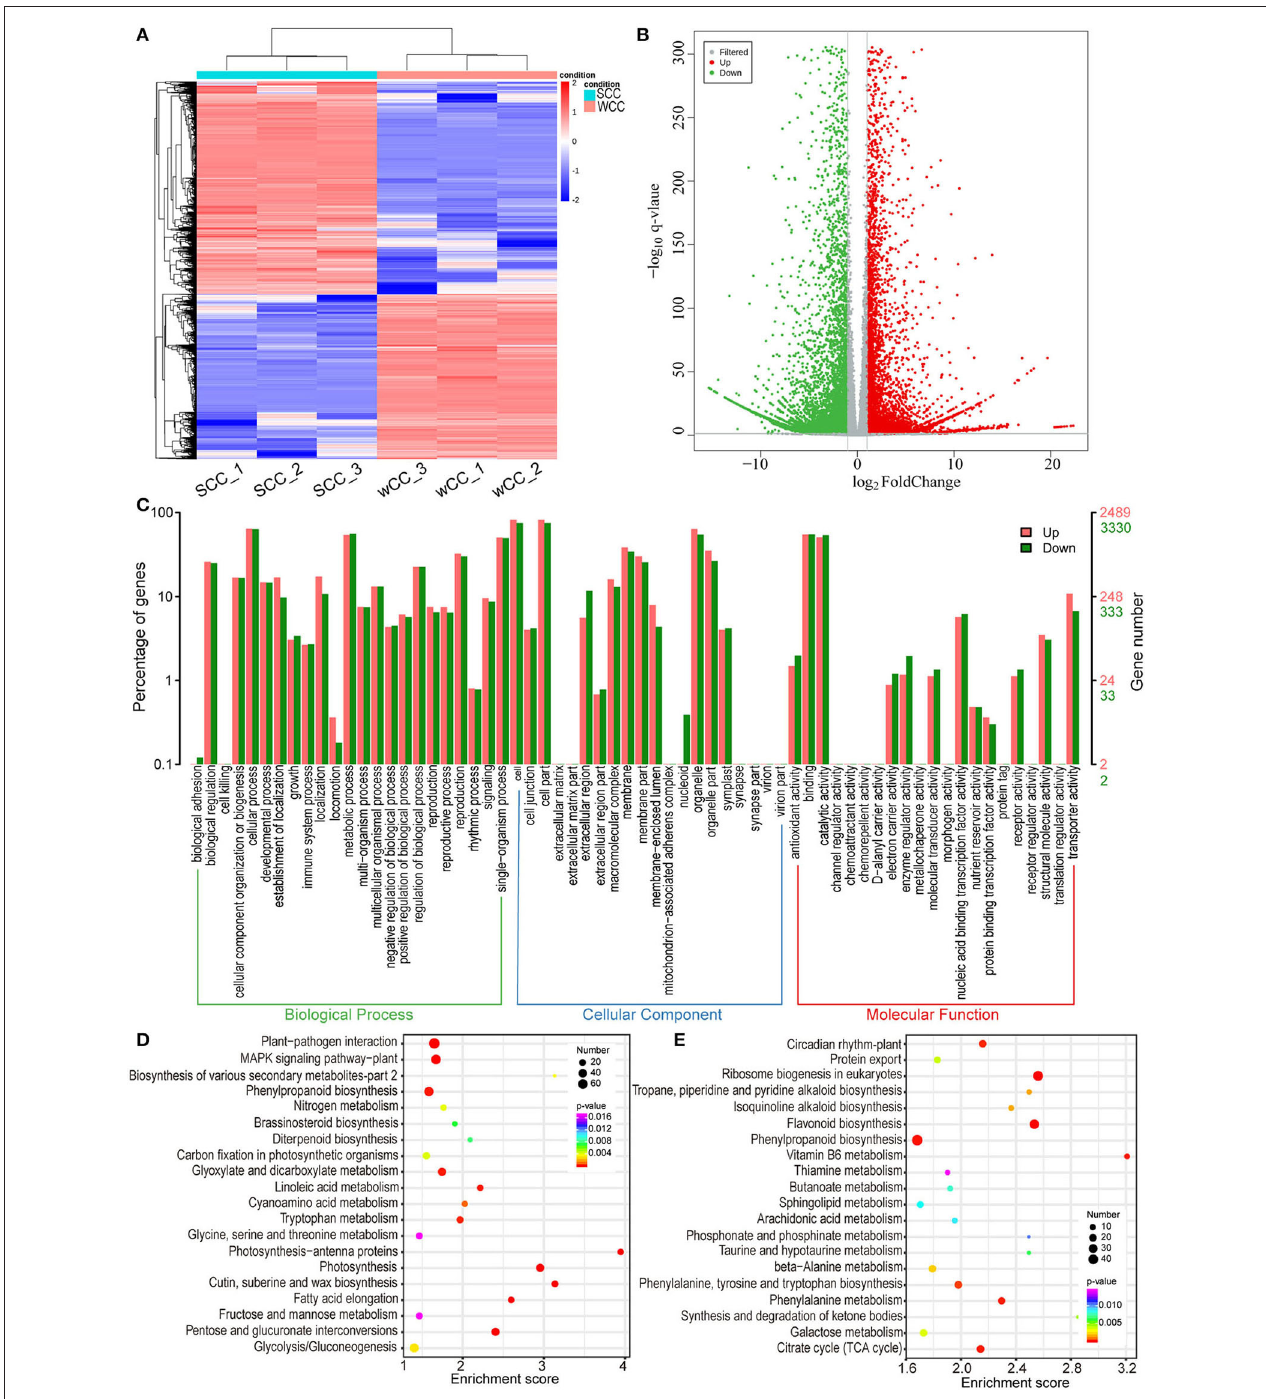
FIGURE 4 | Functional classification of differentially expressed unigenes (DEGs). (A) Hierarchical clustering heatmap of DEGs. Each column and row represent a sample and a DEG, respectively, and the colors indicate the expression levels of DEGs. SCC and WCC, summer and winter Chinese cedar needle samples, respectively, and SCC_1, SCC_2, and SCC_3 represent 3 repetitions. (B) Volcano plot of DEGs. Each point in the volcano plot represents a unigene, the abscissa represents the logarithm of the quantitative difference multiples of a unigene in two samples, and the ordinate represents the significance level of DEGs. The blue/red dots in the figure represent down/upregulated DSMs, and the gray dots represent metabolites that were detected but not significant. (C) Comparison of the distribution of DEGs at the GO level. Red/green indicates GO entries enriched for up/downregulated DEGs; the x -axis is the name of the entry, and the y -axis represents the number of unigenes in the corresponding entry and their percentages. KEGG enrichment analysis of downregulated (D) and upregulated (E) DEGs in WCC needles. The x - and y -axes represent the enrichment score and pathway term, respectively. The colors and sizes of the dots represent the significance ( p ) and number of unigenes,